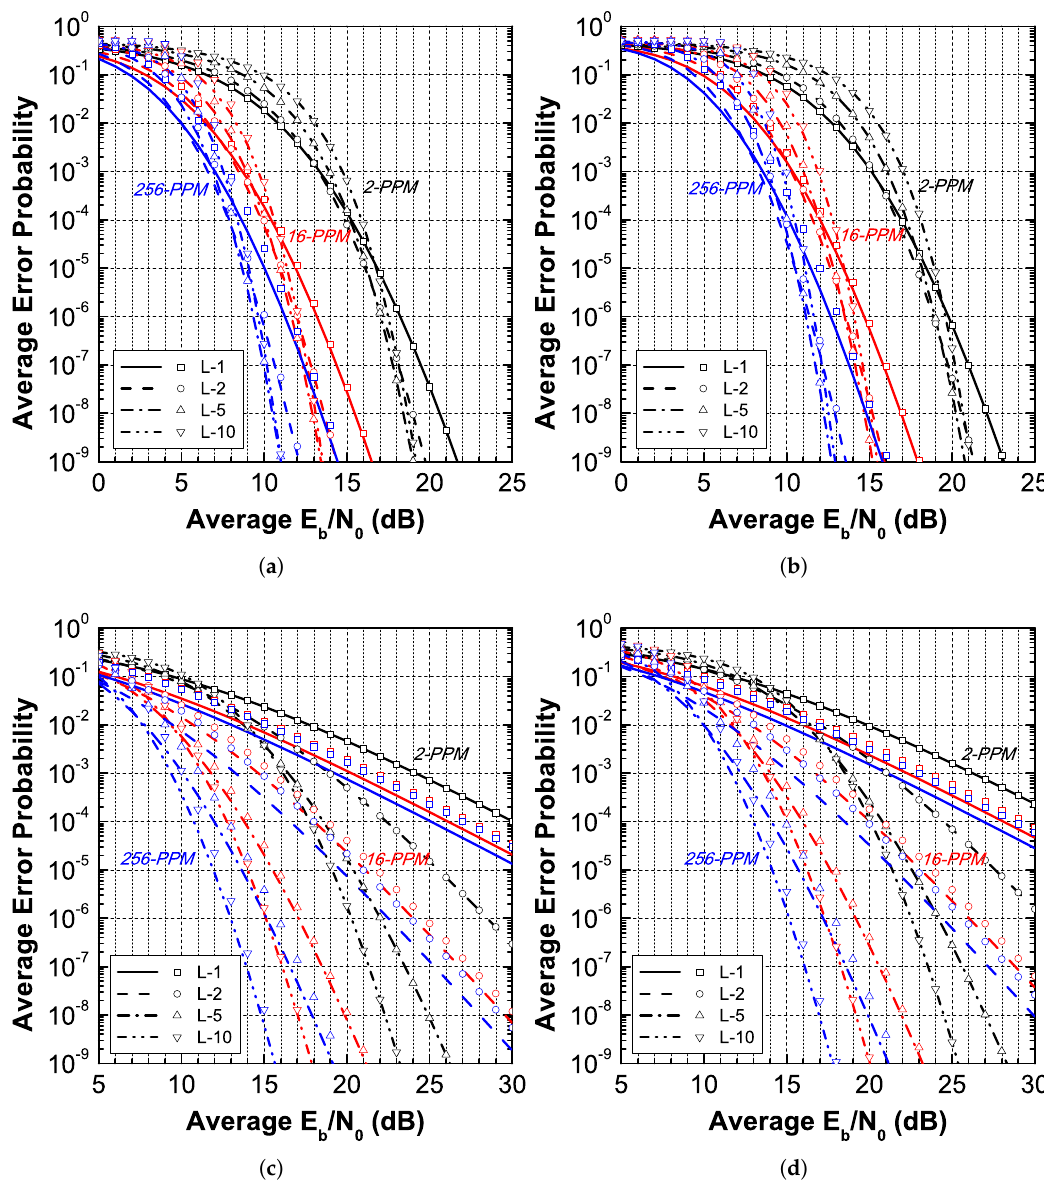
Figure 3. Average PER vs E b / N 0 for Q = 2,16,256 in weak ( top row ) and moderate ( bottom row ) γ − γ fading. The plot lines and points correspond to the exact and approximated results, respectively. The optical noise modes are equal to k = 2 ( left column ) and k = 8 ( right column